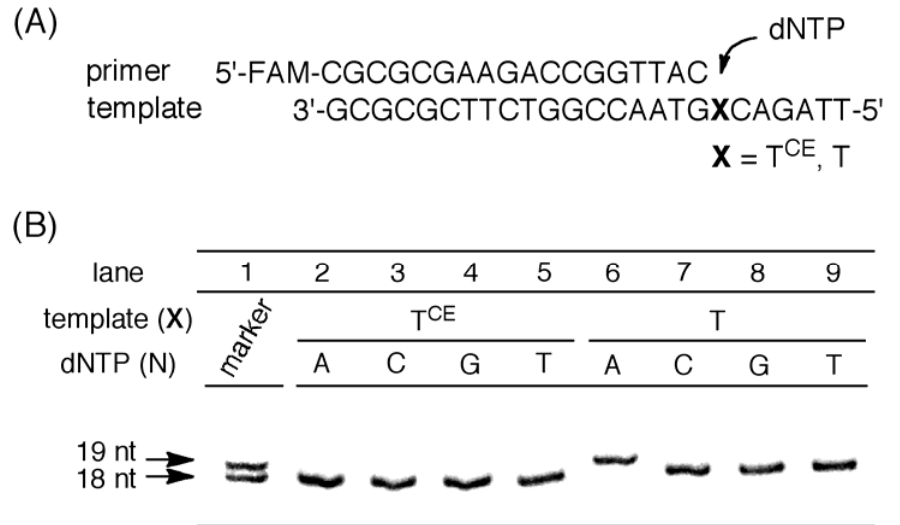
Figure 6. Single dNTP insertion reactions using Taq DNA polymerases. (A) Sequences of 5 ′ -FAM labeled 18-nt primer and 25-nt templates; (B) PAGE analysis of single-insertion